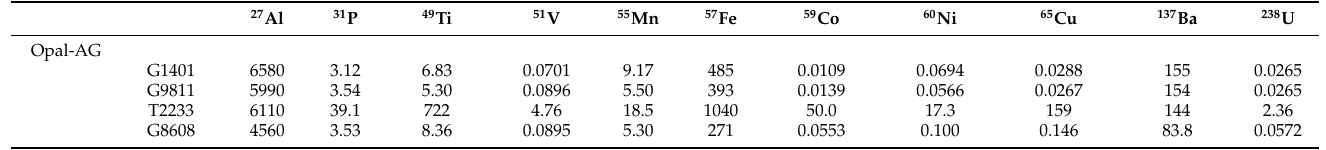
Table A2. Selected Elemental Analyses (ppm by Weight) (see Supplementary Materials for Full